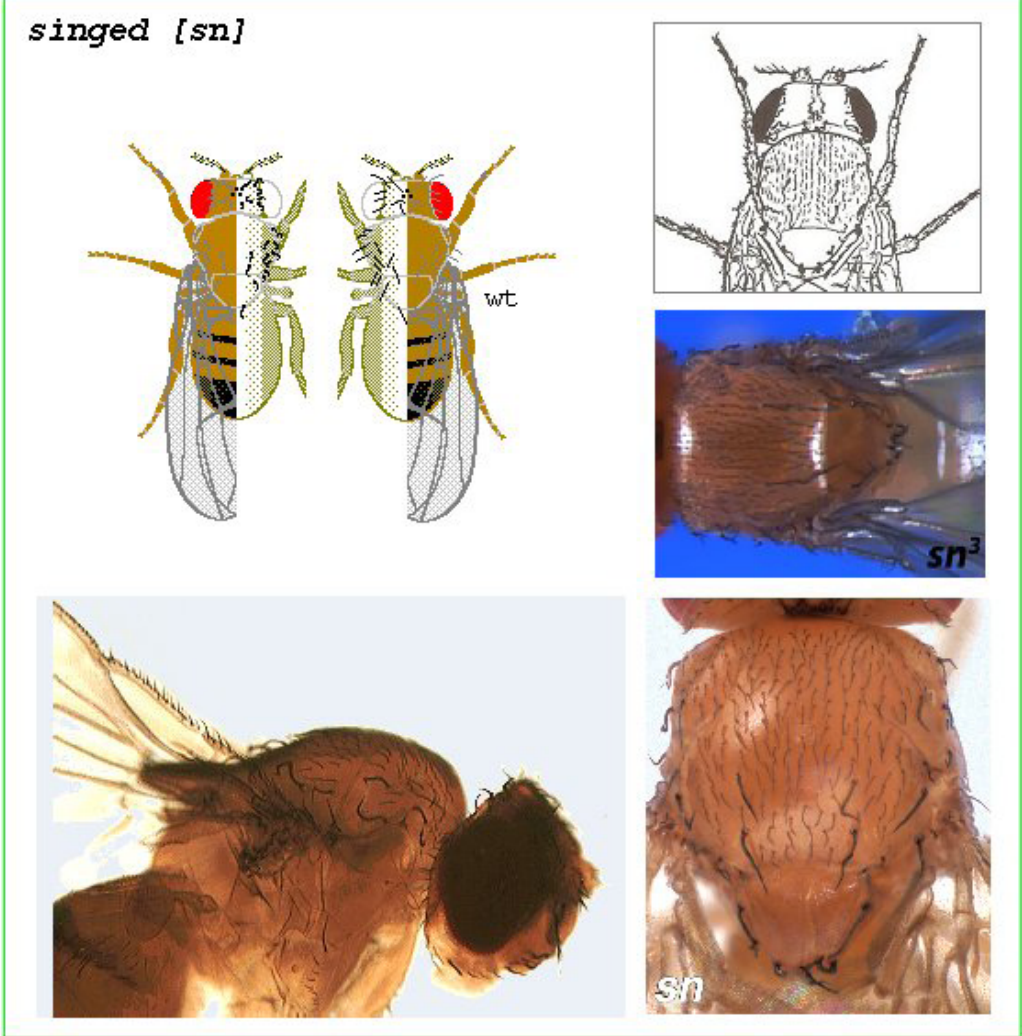
Figure 1 - Box corresponding to the mutant phenotypic character singed in Drosophila melanogaster (details in the text